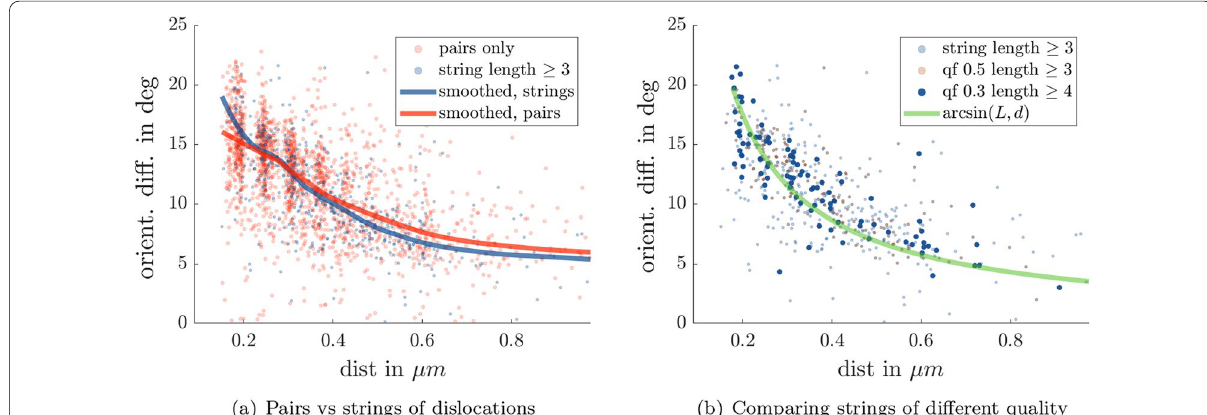
Fig. 2 Comparing the difference in orientation vs median distance in the corresponding strings based on strings with a length of at least 3 (blue) and pairs of dislocations (red) ( a ). Comparing the difference in orientation vs median distance in the corresponding strings of different minimum lengths and quality factors ( b )